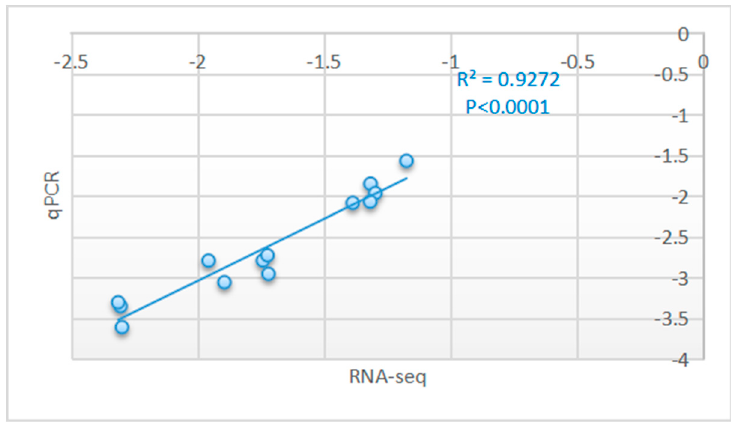
Figure 4. Correlations in the mRNA expression levels of 13 randomly selected DEGs in equine testicular tissues using RNA-seq and qPCR. The x- and y-axes show the log2 ratios of mRNA levels as measured by RNA-seq and qPCR, respectively.